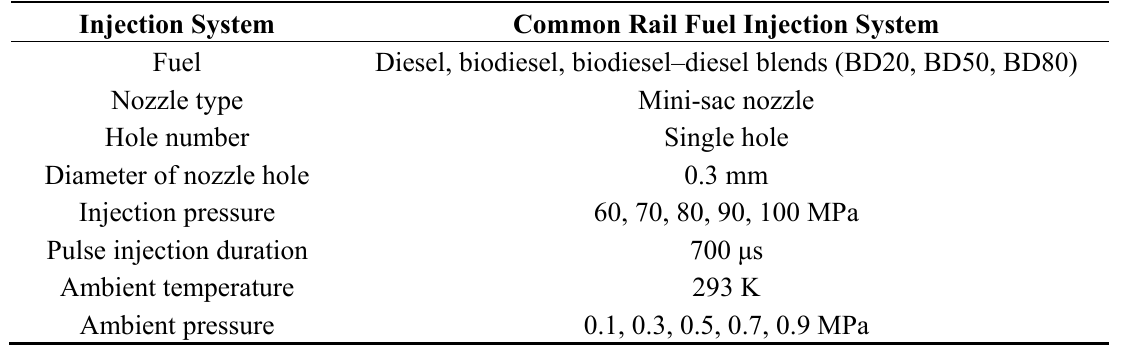
Table 2. The working conditions of the experiment.